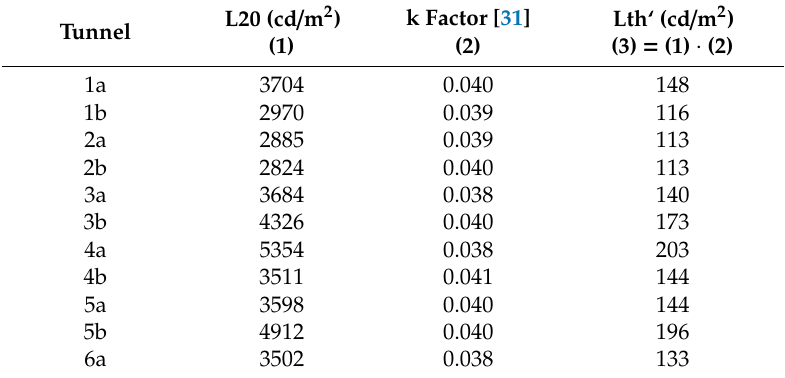
Table 5. Lth‘ values using the L20 access luminance and corresponding k factor according the proposed tra ffi c weighted method [31].